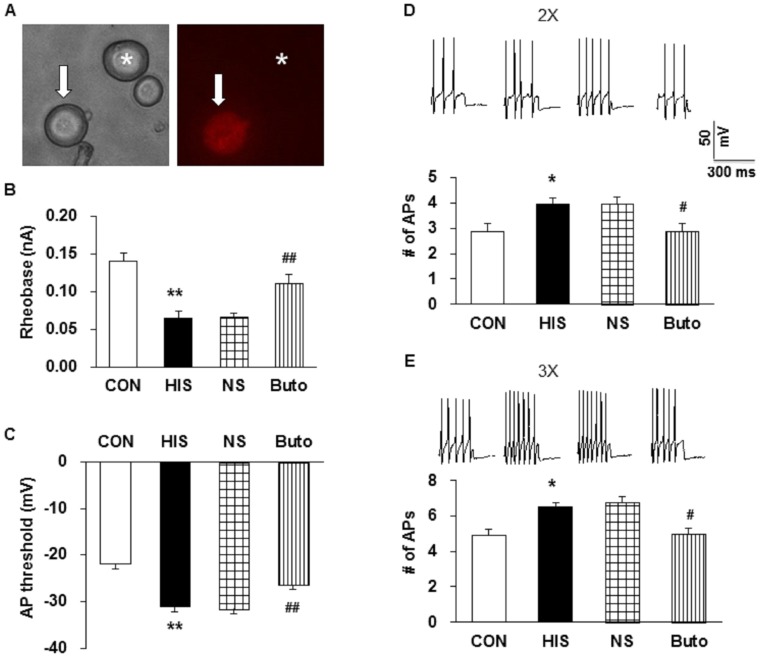
Administration of Butoxamine reversed hyperexcitability.(A) Patch clamp recording were made from DiI-labeled T13-L2 DRG neurons. An example of a DiI-labeled colon innervating DRG neuron is shown in the right panel (arrow). A phase image of the same DRG neuron is shown on the left panel (arrow). A star indicates a neuron without DiI labeling. (B) HIS treatment significantly reduced rheobase. **p<0.01 vs. control (CON). Butoxamine (Buto), which was intraperitoneally injected at the dose of 1.5 mg/kg body weight once a day for 9 days, significantly reversed the effect. ##p<0.01 vs. NS. (C) Graph showing depolarization of AP threshold after Buto treatment. **p<0.01 vs. CON; ##p<0.01 vs. NS. (D, E) Representative traces of APs induced by 300 ms depolarizing current pulses at 2 and 3 times rheobase were shown above. Bar graph showed that the average number of APs evoked by 2 and 3 times rheobase current was significantly reduced by Buto when compared with HIS group, *p<0.05 vs. CON; #p<0.05 vs. NS.